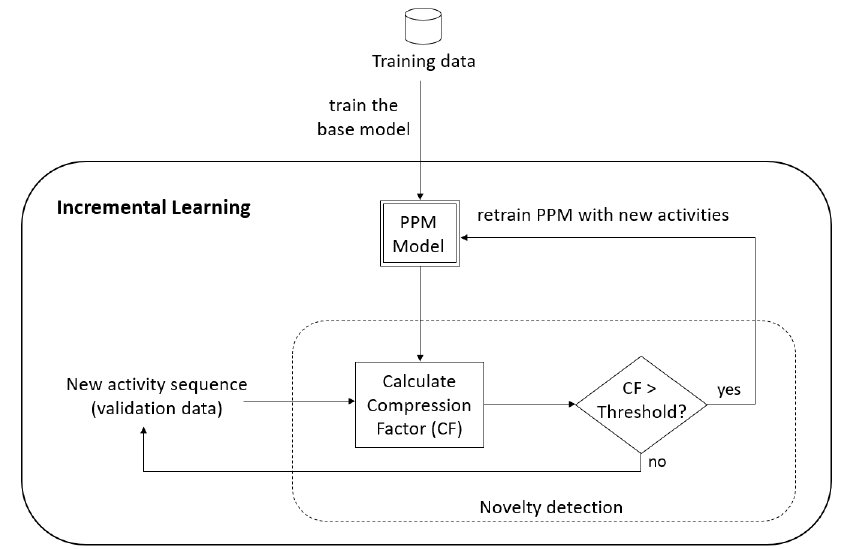
Figure 1. Summary of our proposed